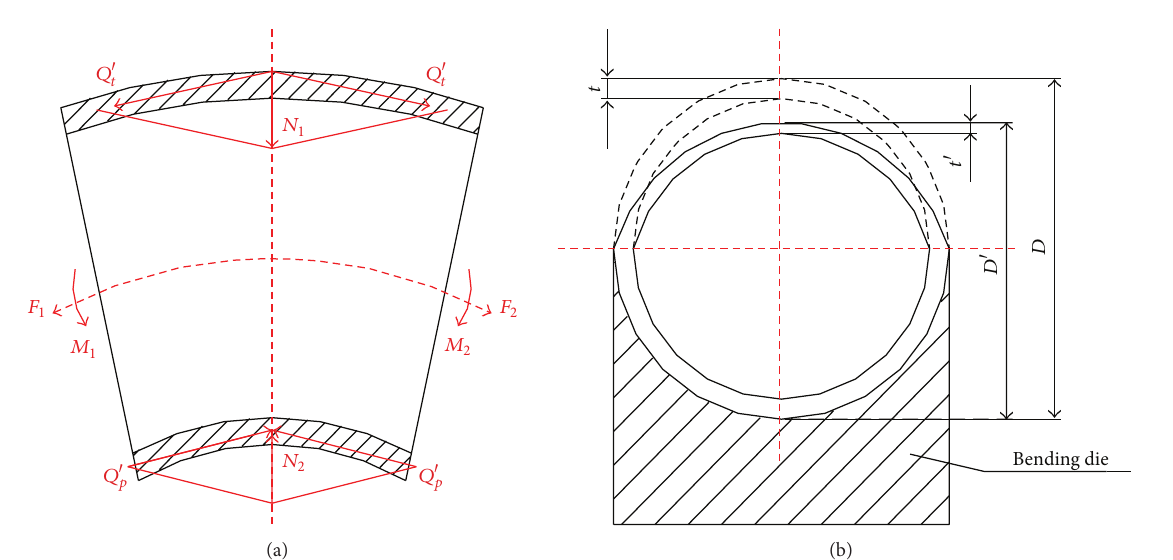
Figure 2: Cross section deformation and wall thinning of tube NC